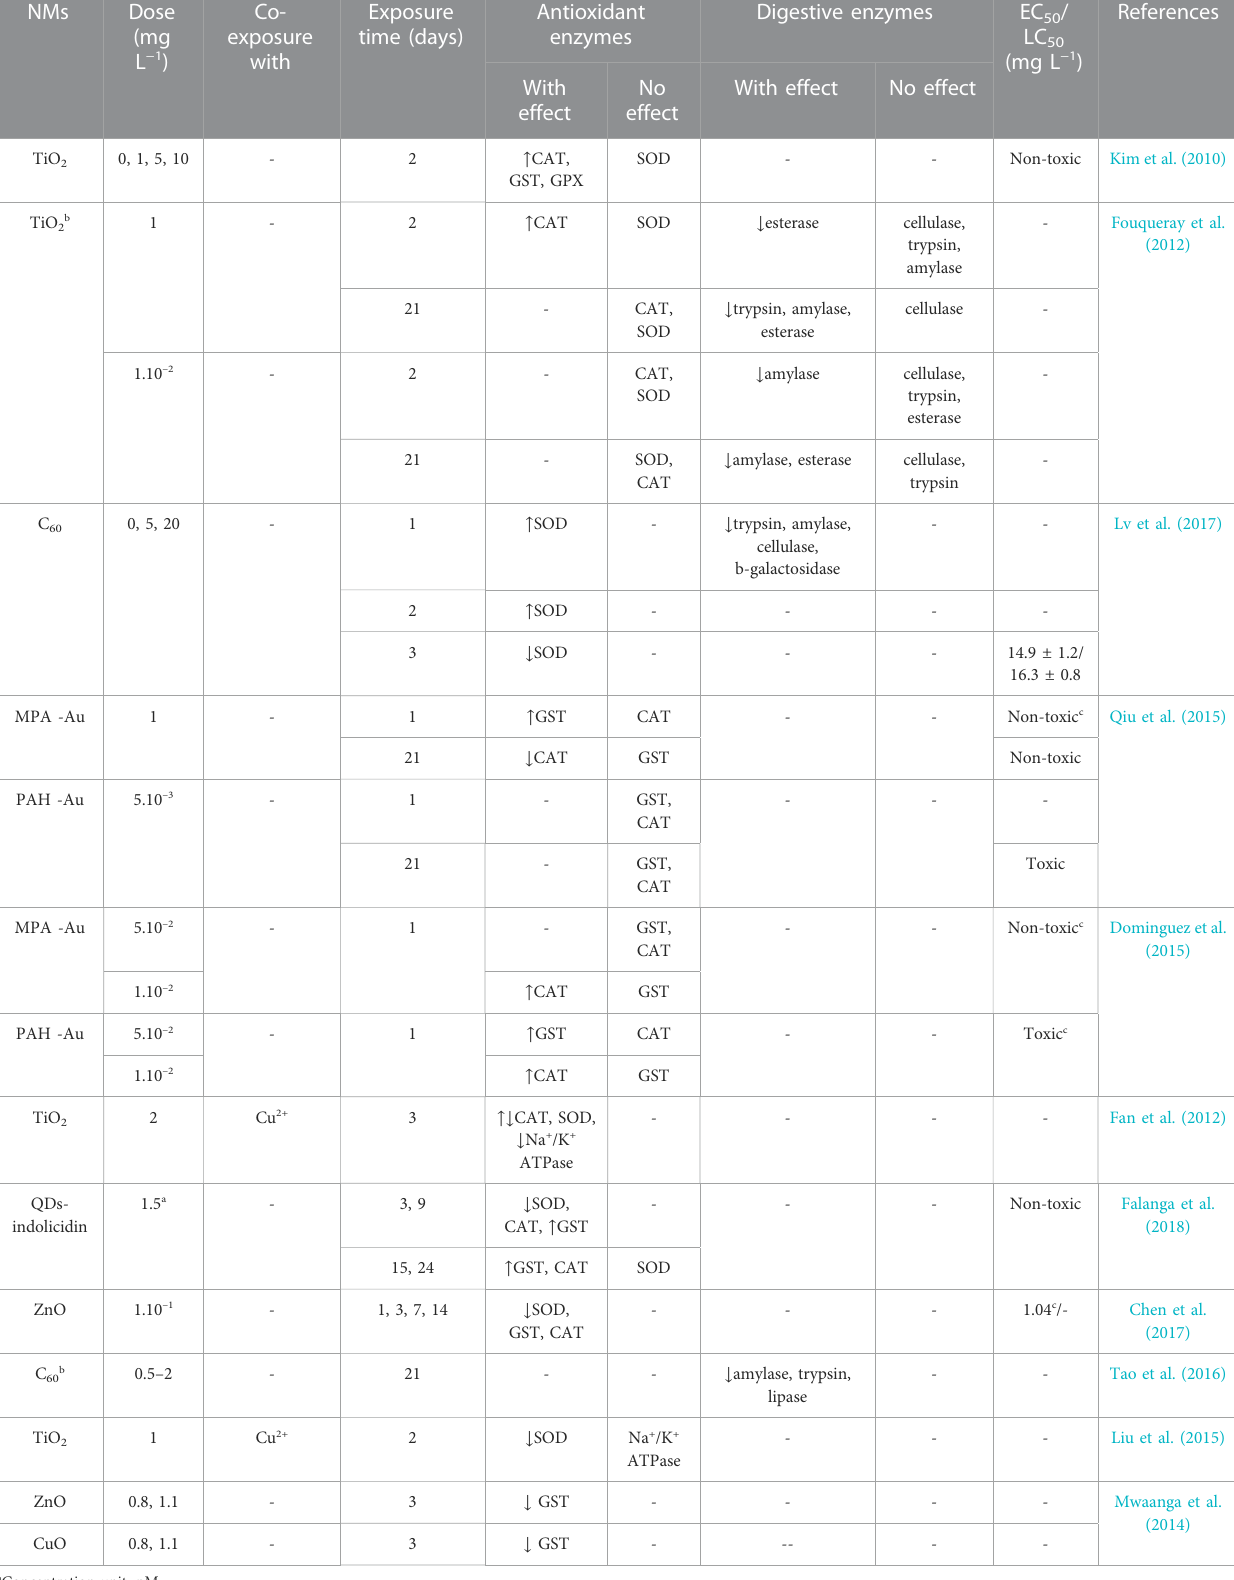
TABLE 2 Effects of exposure of D. magna to NMs on the activity and/or expression of antioxidant and digestive